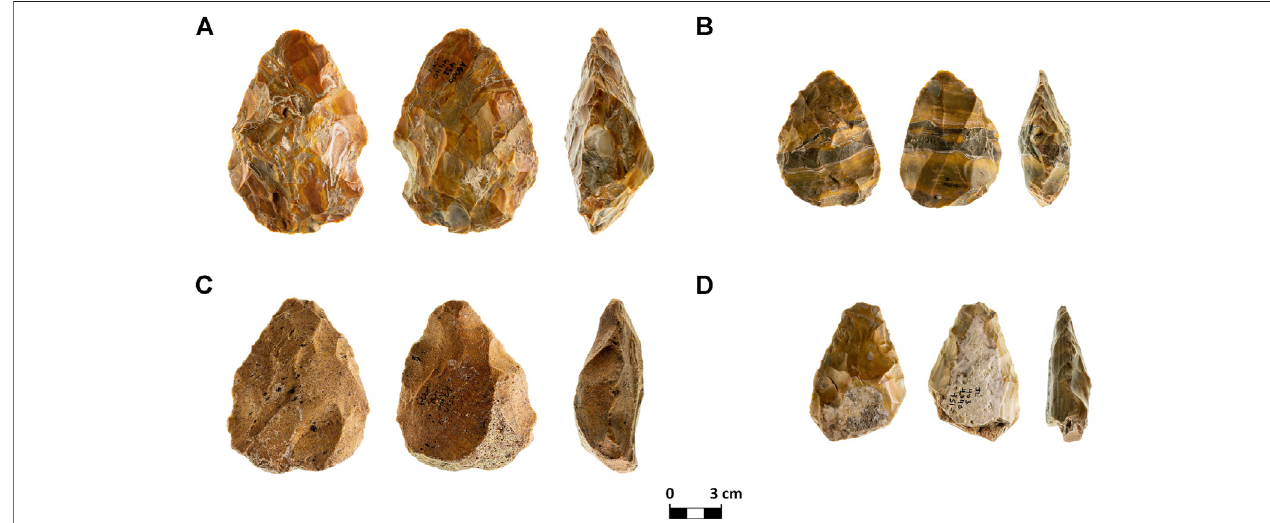
FIGURE 3 | Bifaces from Jaljulia made of fl int types of interest: (A,B) bifaces made of brecciated, heterogenous fl int types (Group 3); (C) a biface made of Eocene fl int, with macroscopically visible nummulites; (D) a biface made of striped homogenous fl int type (Group 8).